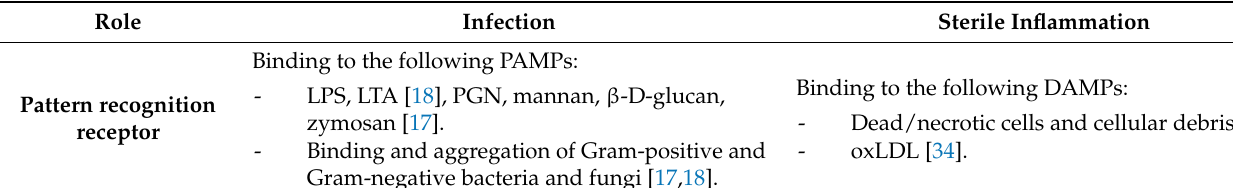
Table 1. Main features of CD5L during infection and sterile